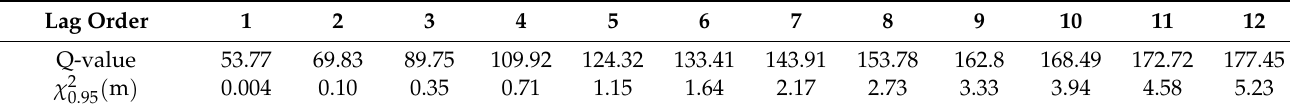
Table 2. Q-value of each lag